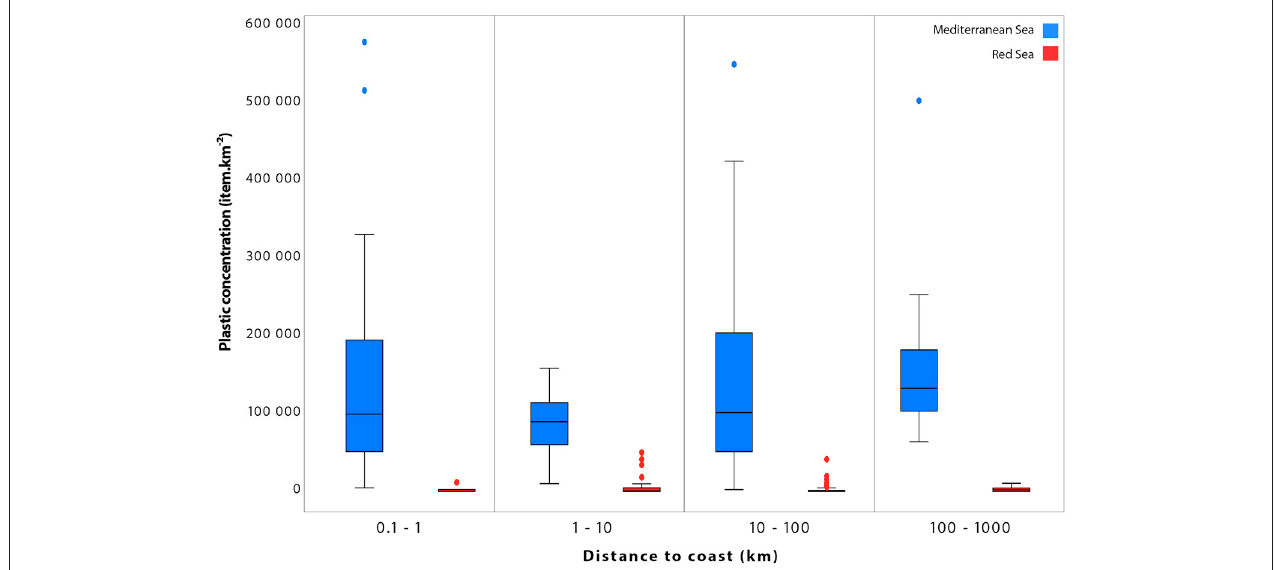
FIGURE 4 | Comparison between floating plastic concentrations in Mediterranean (blue) and Red Sea (red) for different water strips from land (0.1–1, 1–10, 10–100, and 100–1,000km). Data from the Mediterranean are described in Pedrotti et al. (2016). The Mediterranean water strips close to land ( < 10km to land) mainly accounts for the Côte d’Azur in France. Black lines into the boxes indicate median values, boxes indicate first and third quartiles, and whiskers indicate the 90 and 10th